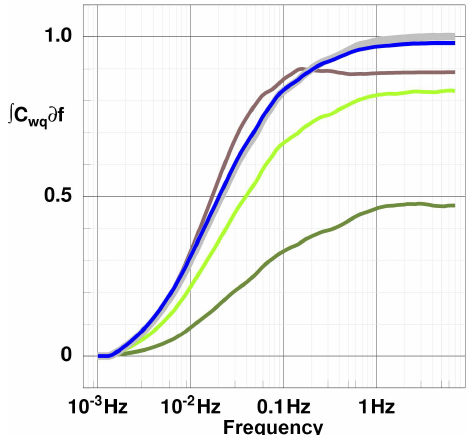
Figure 10. Ogive functions (integral over the latent heat fluxes) for the Do128 flight on 23 October 2015. The colours indicate the same humidity sensors as in Fig.